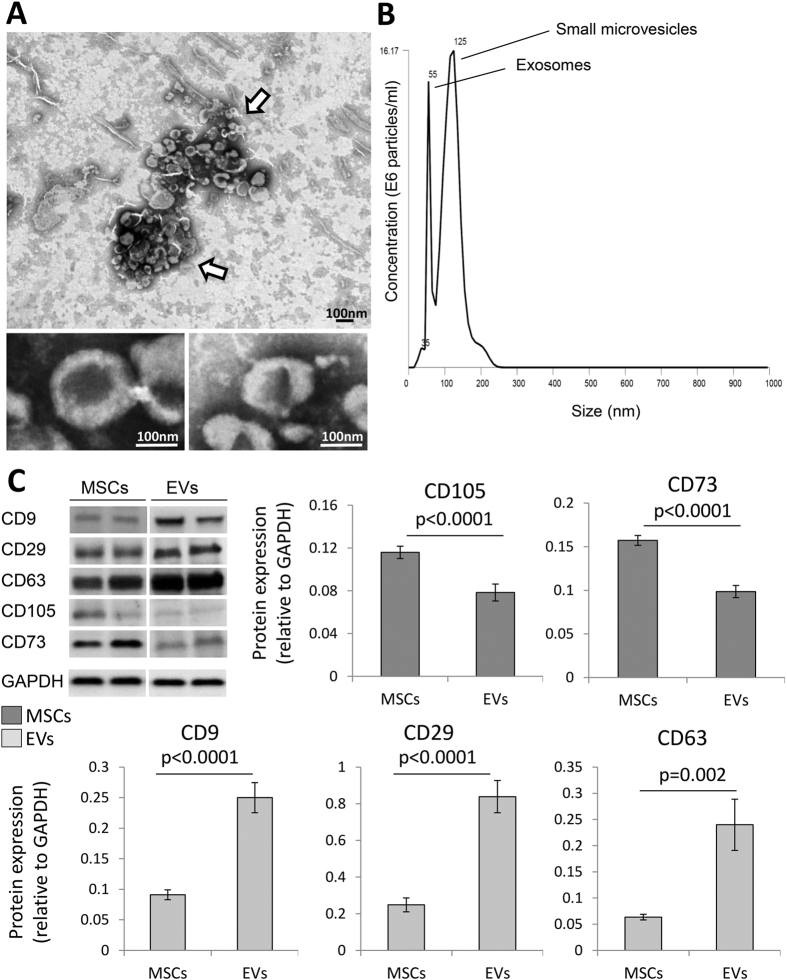
(A) Transmission electron microscopy of MSC culture supernatants (negative staining) showing EV clusters (arrows) with the classic “cup-like” morphology. (B) Size distribution of isolated EVs revealed a composition of about 2/3 small microvesicles (~125 nm in size) and 1/3 exosomes (~55 nm). (C) MSC and EV protein expression of common MSC (CD105 and CD73) and EV (CD9, CD29, and CD63) markers.